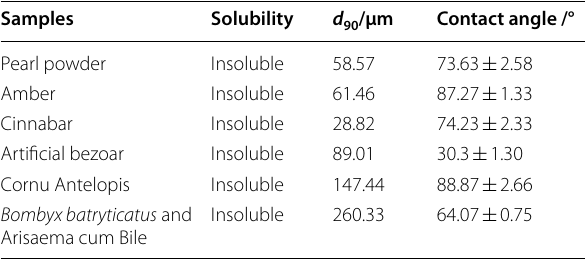
Table 1 Results of the study